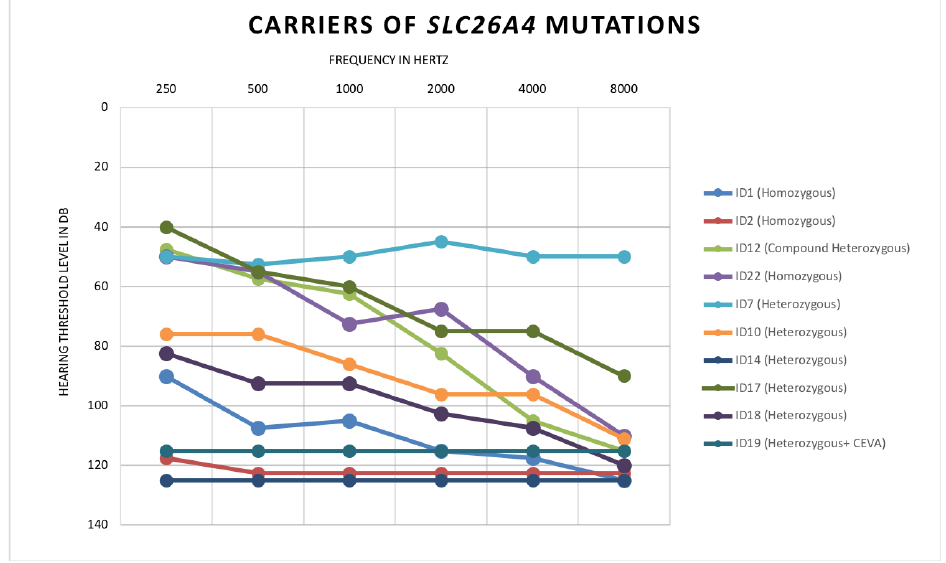
Figure 2. Audiograms of the carriers of SLC26A4 mutations. Audiometric features, displayed as audiograms, of the ten patients resulted in being carriers of SLC26A4 homozygous or heterozygous mutations. The hearing threshold levels are reported as the mean value between the right and the left ear.